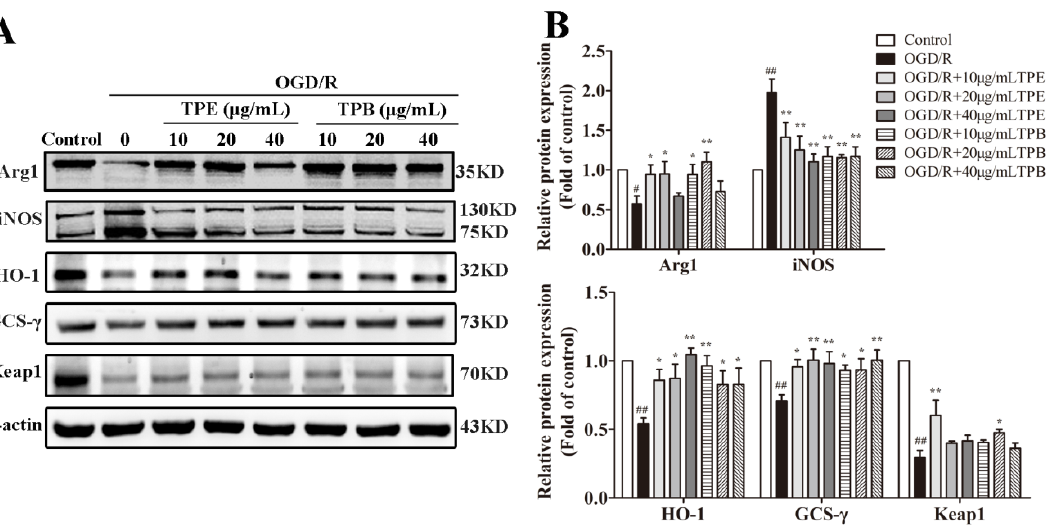
Figure 6. OGD/R-injured cells were treated with TPE or TPB. ( A ) TPE and TPB concentrations on the expression of Arg1, iNOS, HO-1, GCS- γ , Keap1. ( B ) Relative protein values were normalized to those of the control group using a histogram. # p < 0.05, ## p < 0.01 vs. control group, * p < 0.05, ** p < 0.01 vs. OGD/R group.